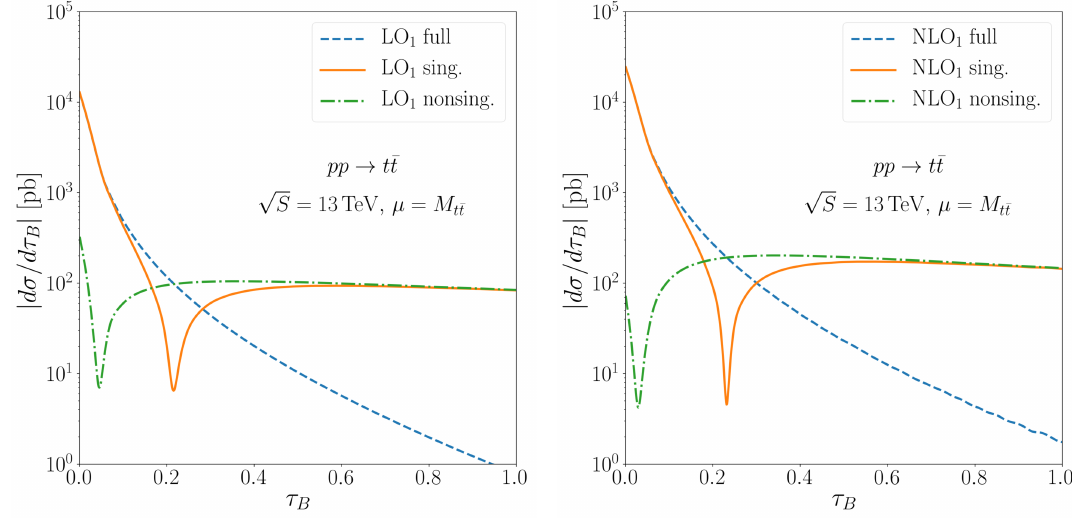
Figure 2 . Comparison of the absolute values for the singular and nonsingular contributions to the T 0 distribution with fixed order results at LO (left) and NLO (right)